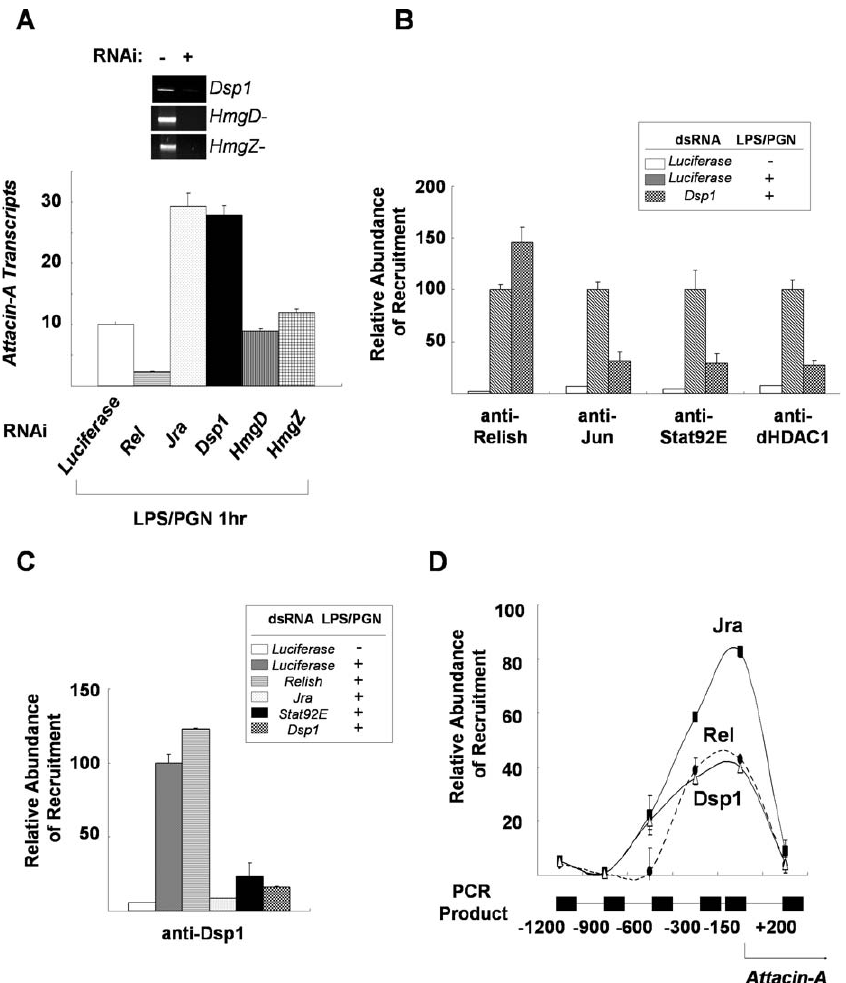
Figure 4. Dsp1 Plays a Crucial Role in the Interactions between Jra and Stat92E (A) Down-regulation of Attacin-A transcripts by HMG protein. Real-time PCR analysis showing Attacin-A transcript levels after 1 h of LPS/PGN treatment of SL2 cells depleted by RNAi of the transcription factors and HMG proteins indicated below the histograms. The levels were normalized with RpL32 transcripts. The extents of depletion of the corresponding transcripts by RNAi are shown in the top panel. (B) Dsp1 is required for binding of Jra, Stat92E, and dHDAC1 to the Attacin-A promoter. SL2 cells were incubated with Luciferase or Dsp1 dsRNA for three days, then used in ChIP assays with ( þ ) and without ( (cid:2) ) LPS/PGN treatment (10 l g/ml for 1 h). The amounts of Attacin-A promoter fragments co- precipitated with the antibodies were normalized for the input used in each assay and are shown with standard deviations. These experiments were repeated at least three times independently. (C) Requirement for Jra and Stat92E for recruitment of Dsp1 to the Attacin-A promoter. SL2 cells were depleted of the protein indicated on the right by RNAi, then used in ChIP assays before ( (cid:2) ) and after ( þ ) LPS/PGN treatment. The amounts of Attacin-A promoter co-precipitated with anti-Dsp1 antibody in the ChIP assays are shown with standard deviations. These experiments were repeated at least three times independently. (D) The amounts of chromatin fragments co-precipitated with anti-Jun (solid squares), anti-Dsp1 (open triangles) or anti-Relish (solid circles) antibodies in the indicated regions of the Attacin-A promoter were measured by real-time PCR in a Roche Lightcycler, and the averages and standard deviations of three independent experiments are plotted.